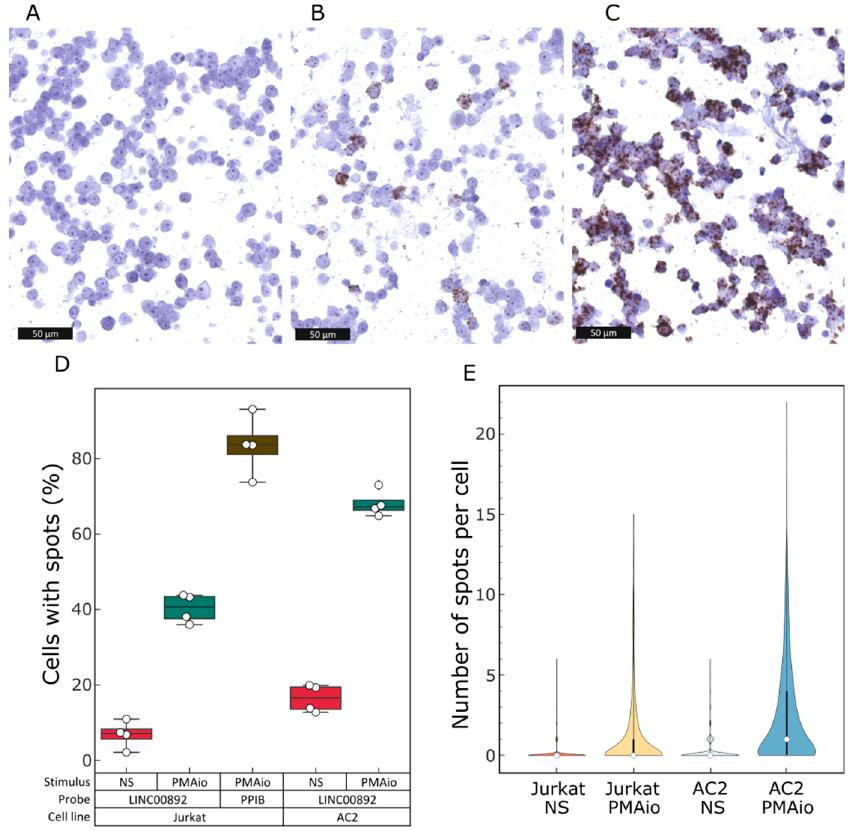
Figure 5. Single-cell analysis of LINC00892 expression in Jurkat cells. ( A – C ) In situ hybridization (ISH) analysis in non-stimulated Jurkat cells ( A ) or Jurkat cells stimulated with PMA and ionomycin and left growing for 48 h after stimulus withdrawal ( B , C ). Cells in ( A , B ) were stained with a probe specific for LINC00892. Cells in ( C ) were stained with a probe specific for cyclophilin B (PPIB). ( D ) Quantification of the number of cells having specific ISH spot signals in samples from parental Jurkat cells and from a sub-clone of the same Jurkat cells (AC2), using software for image analysis. For each condition, 4 different regions of interest (ROI) were analyzed. ( E ) Image analysis quantification of the number of spot per cell in samples from parental Jurkat cells and from a sub-clone of the same Jurkat cells (AC2).